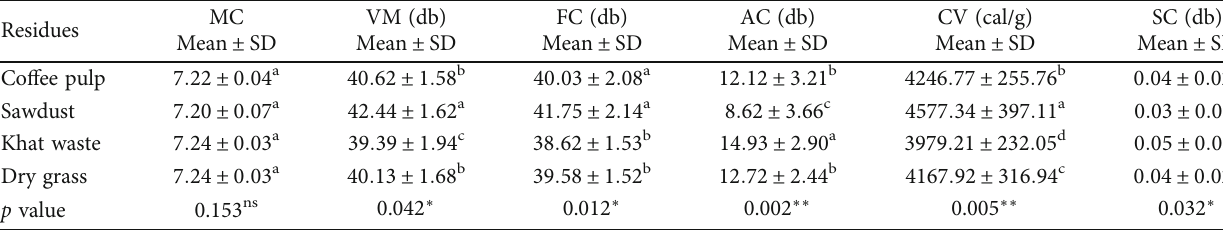
Table 1: Mean proximate and ultimate analysis of the sample